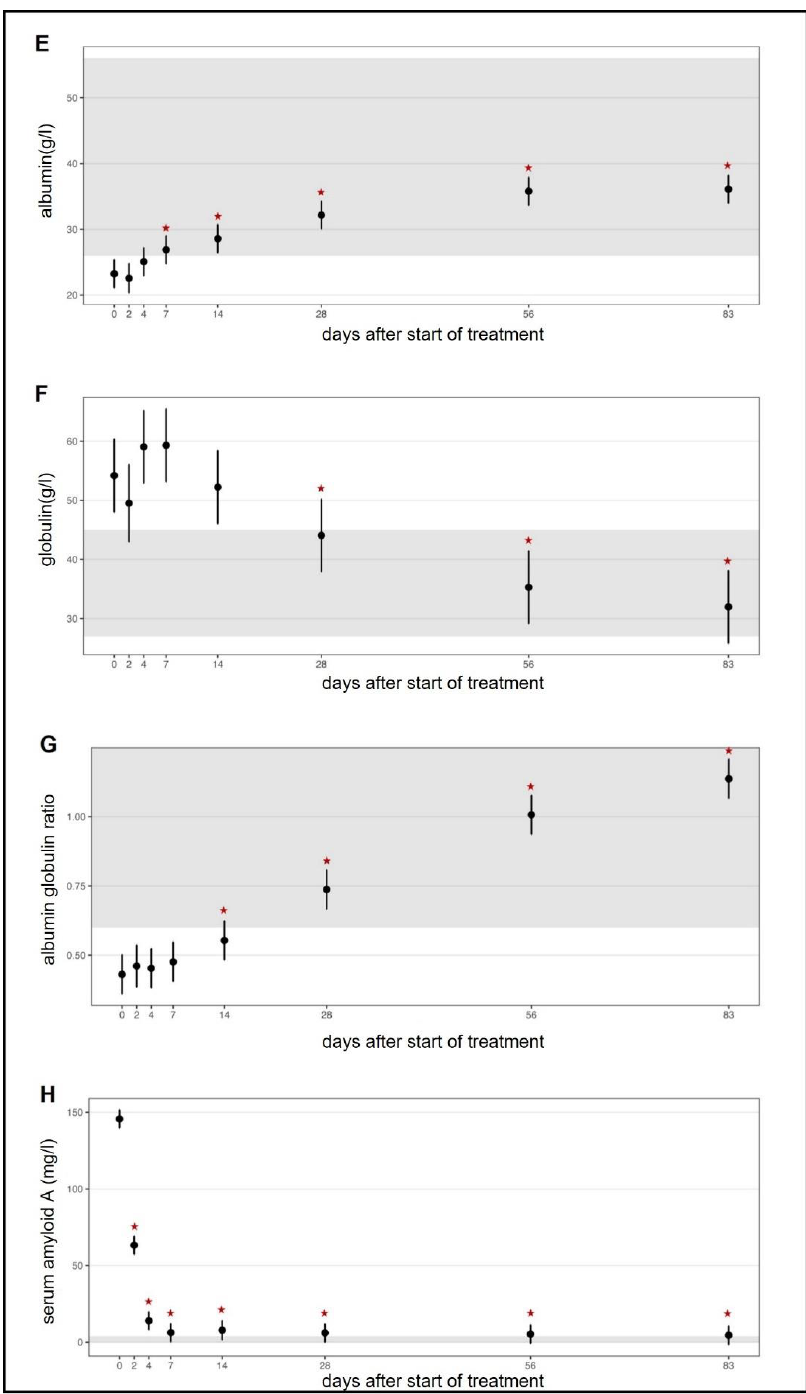
Figure 4.2 Figure 4. Timeline visualizing improvement of clinicopathological parameters throughout the study course. Figures show average predictive values and 95% confidence intervals of each parameter. Grey shading marks the reference ranges of the parameters. Red asterisks mark significant difference ( p ≤ 0.05) of the parameters on different days of treatment when compared to day 0 (before treatment) measured by a linear mixed-effects model (for albumin) and by robust linear mixed-effects models. ( A ) Hematocrit. ( B ) Lymphocyte count. ( C ) Bilirubin concentration. ( D ) Total protein concentration. ( E ) Albumin concentration. ( F ) Globulin concentration. ( G ) Albumin/globulin ratio. ( H ) Serum amyloid A (SAA)